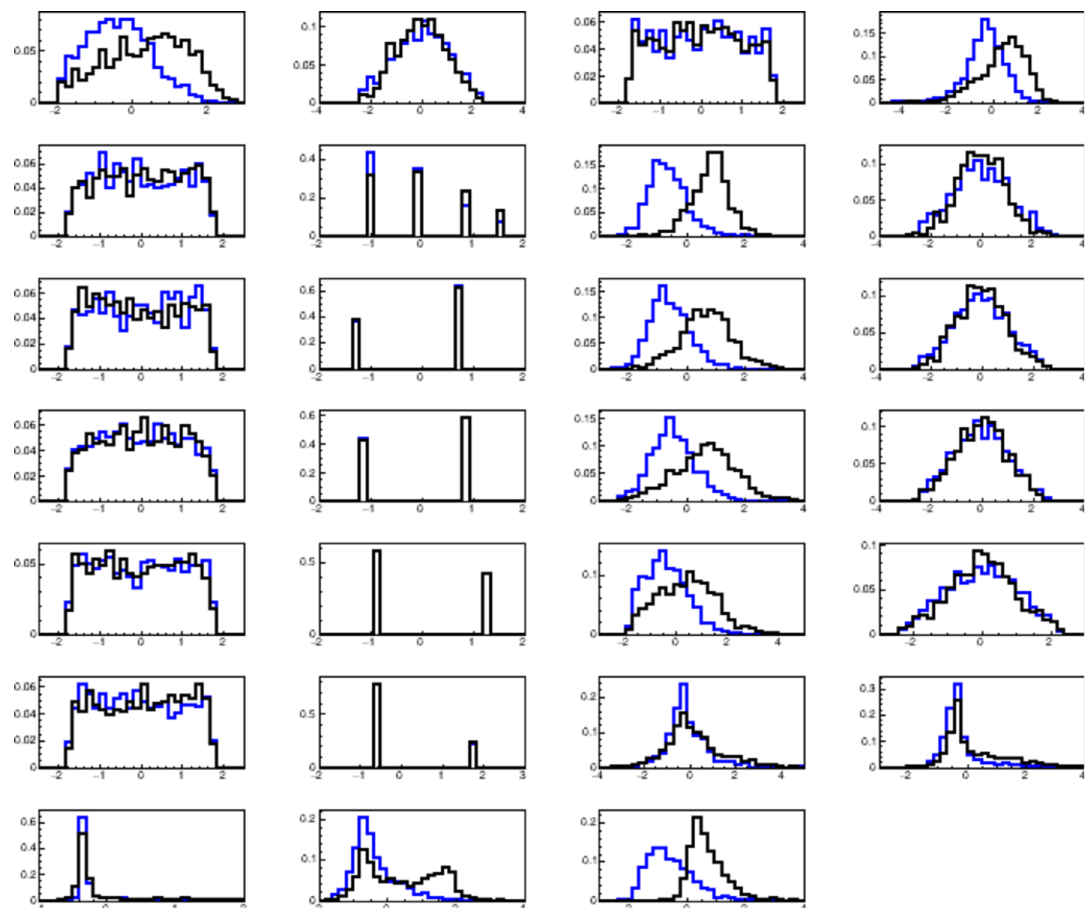
Figure 11 . Normalized and standardized distributions of the 27 features of HEPMASS data for signal (black) and background